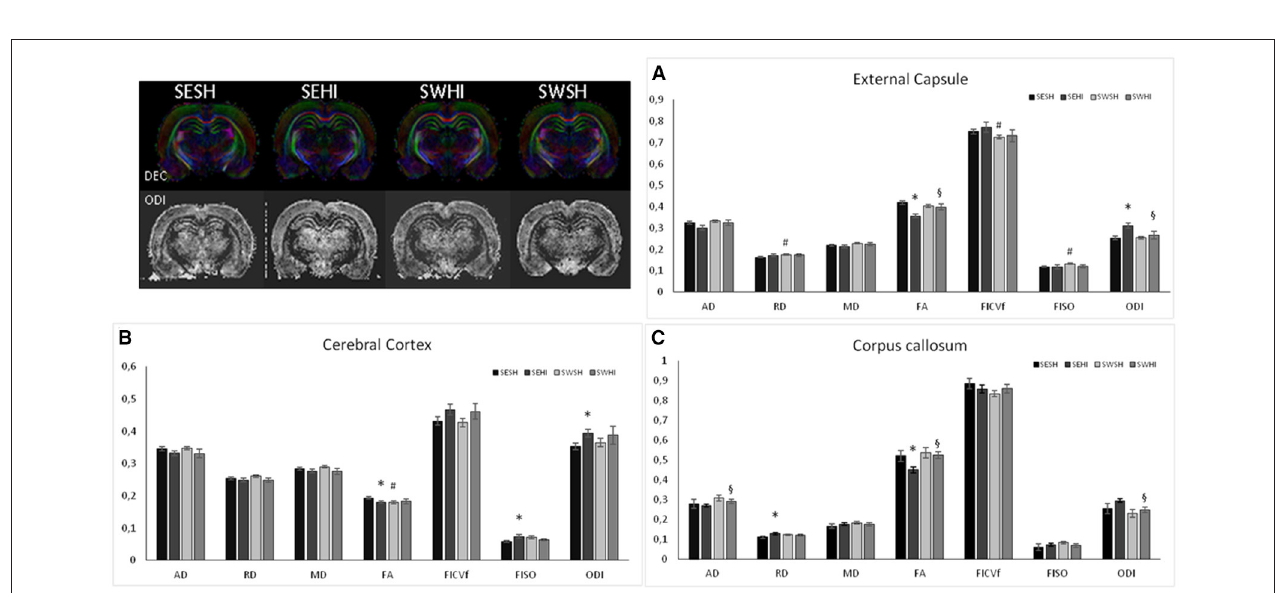
FIGURE 5 | Water Maze performance during the 5 days of training (left upper panel). (Right upper panels) - performance on the probe trial. Data are expressed as mean ± SEM ( n = 8–16). Lower panels show the representative plots of the Probe Trial. The results were analyzed by two-way ANOVA followed by Duncan’s post-hoc test. Significance was accepted when p < 0.05. *SEHI vs. SESH.